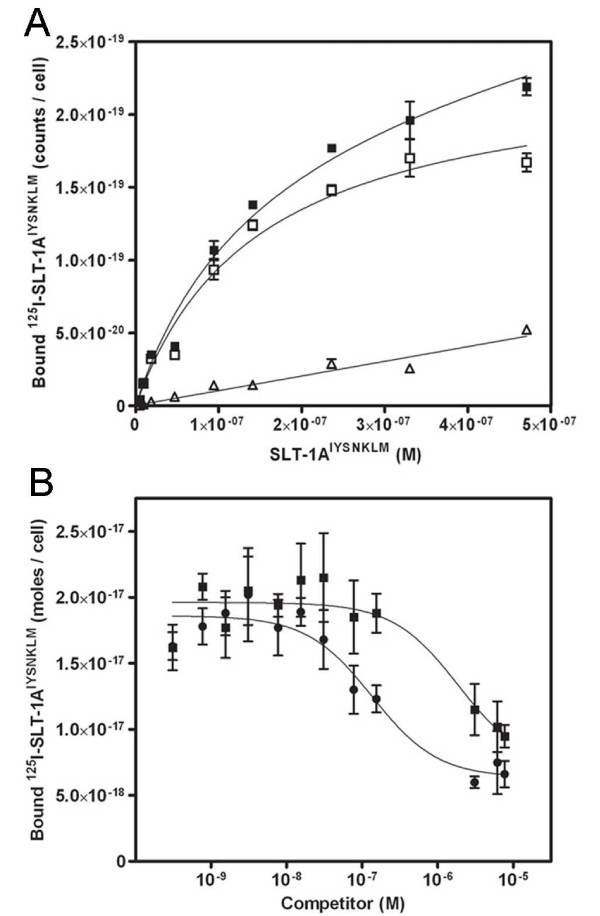
Binding of 125I-SLT-1AIYSNKLM to 518-A2 cells. (A) Specific binding (white squares), total binding (black squares), and non-specific binding (white triangles) of 125I-SLT-1AIYSNKLM to 518-A2 cells at 4°C. (B) Displacement curves in which 518-A2 cells were treated with 45 nM of 125I-SLT-1AIYSNKLM in the presence of increasing concentrations of either unlabeled SLT-1AIYSNKLM (black circles) or a synthetic 16-residue peptide containing the inserted 7-amino acid peptide ligand (HHHIYSNKLMASRVAR) (black squares). Data points represent the s.e.m. of experiments performed in triplicate.